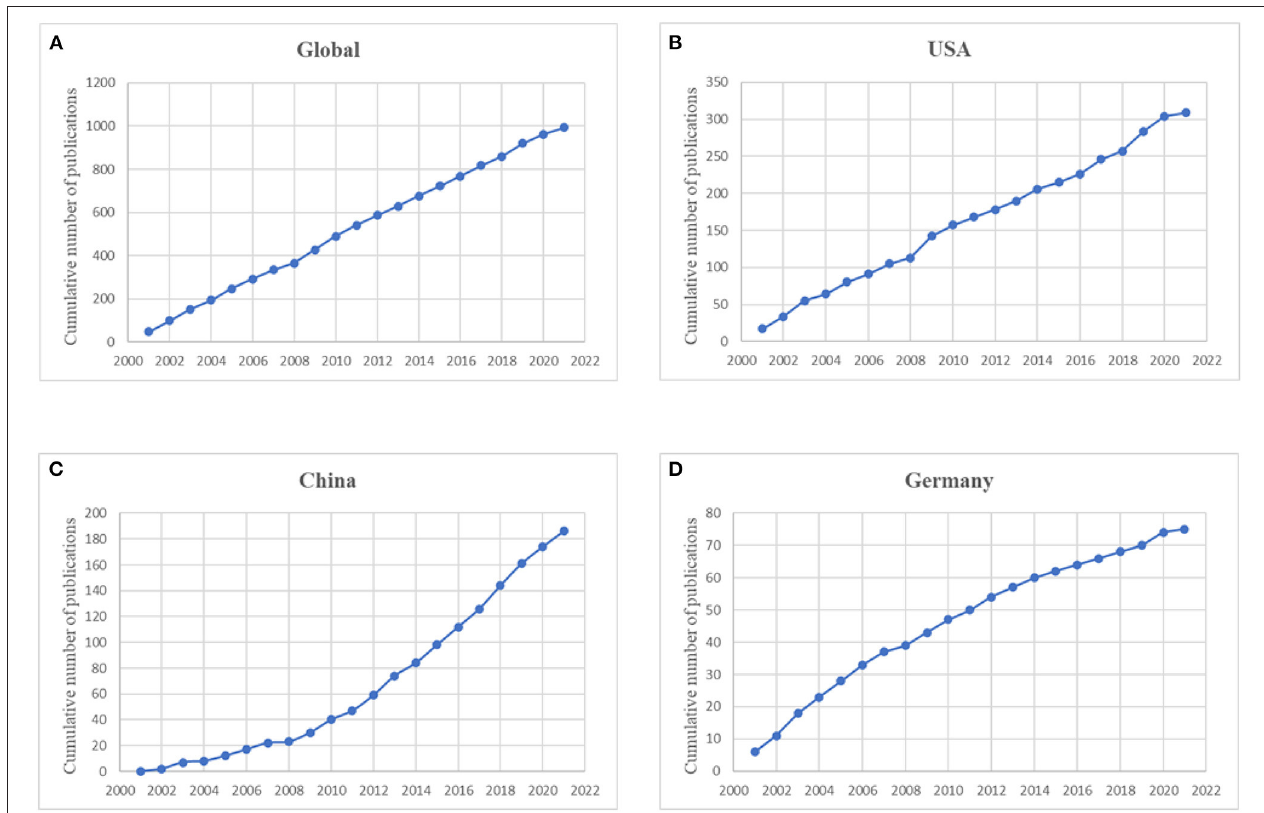
FIGURE 3 | The model fitting curves of growth trends of publications related to MODS. (A) Global; (B) the United States; (C) China; (D)